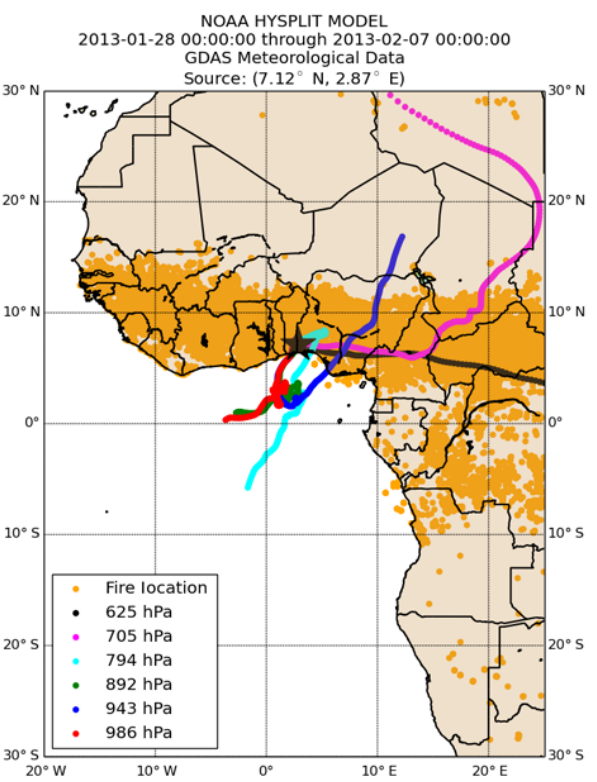
Figure 10. Mean DJF TES NH 3 transect over the Lagos